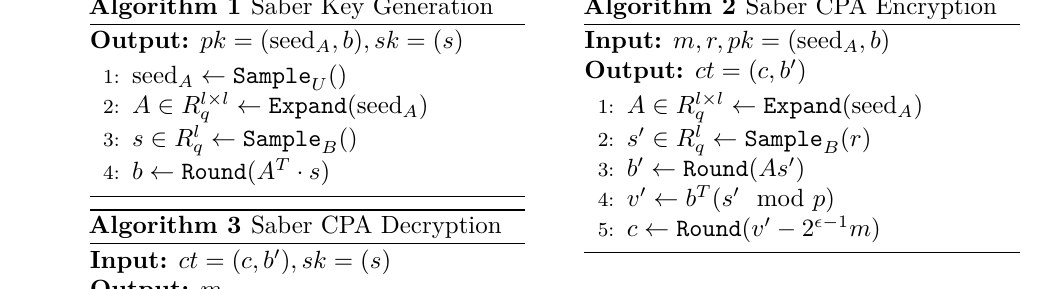
Algorithm 2 Saber CPA Encryption